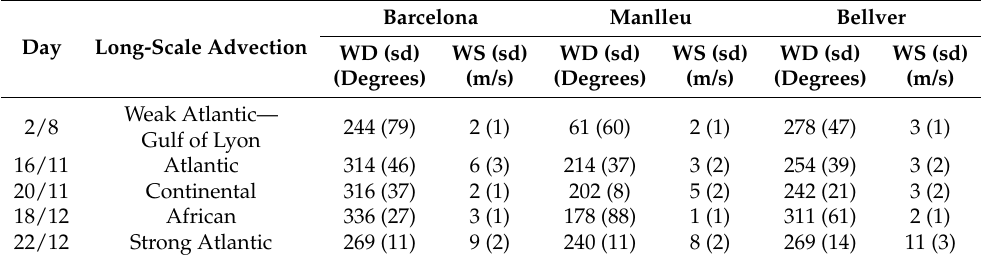
Table 1. Long scale advections of the studied days and daily average of modeled 10 m Wind Speed (WS) and Wind Direction (WD) with the Standard Deviation